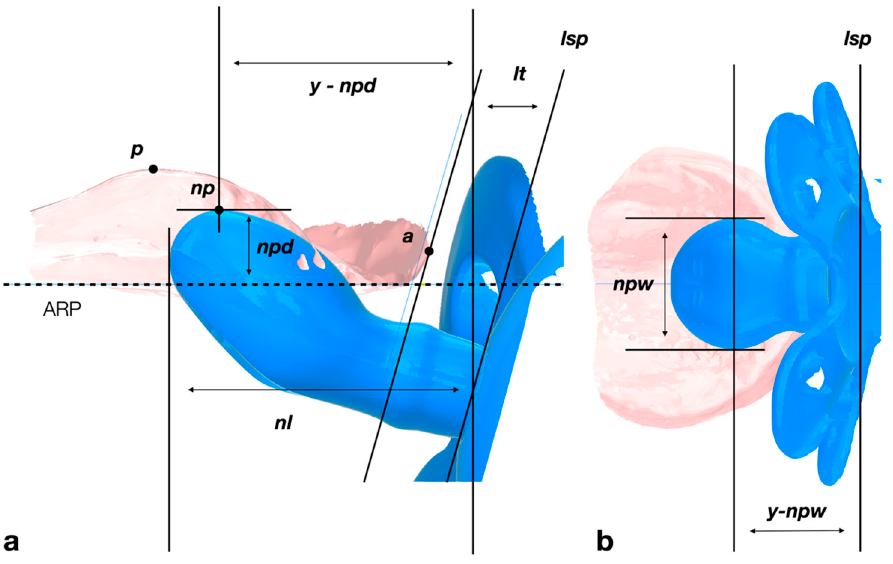
Figure 3. Measurements according to spatial orientation of the pacifier on the infant’s palate. ( a ) Lateromedial view on a median section through palate and pacifier. The pacifier is angulated according to the angle between the alveolar ridge plane (ARP, a parallel to Camper’s line) and the lip shield plane ( lsp ). The horizontal orientation is determined by the lip thickness ( lt ), a distance between the lip shield plane ( lsp ) and the most anterior point of the palate ( a ). The vertical position is determined by the first contact to the palatal shape. In this orientation, the nipple’s palatal depth ( npd ) is the distance between ARP and the most superior point of the nipple. The length y-npd is the distance between point a and the highest point of the nipple ( np ) in the anteroposterior (y-) direction, parallel to ARP. The nipple length ( nl ) is the distance between the lip shield plane and the most posterior border of the nipple, parallel to ARP. ( b ) Inferosuperior view on the palate is according to the left figure. The pacifier is aligned towards the median plane of the palate. The nipple’s palatal width ( npw ) is the largest width of the pacifier, and y-npw is the distance from npw to lsp .